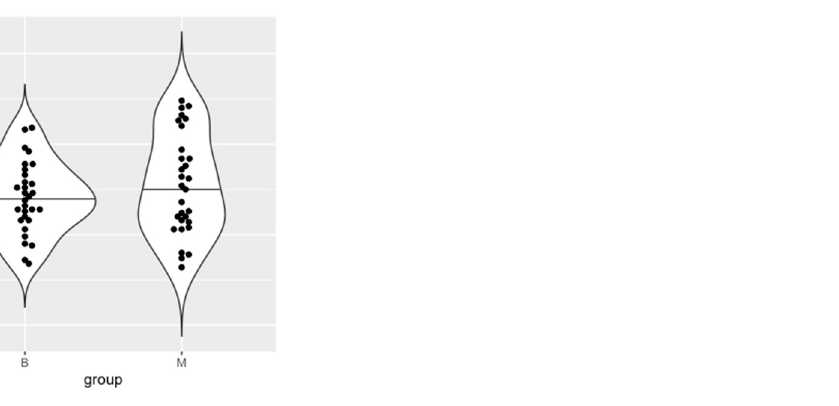
Figure 2. Distribution of deviation scores for the analyzed sentences according to learner group (left: group B; right: group M).